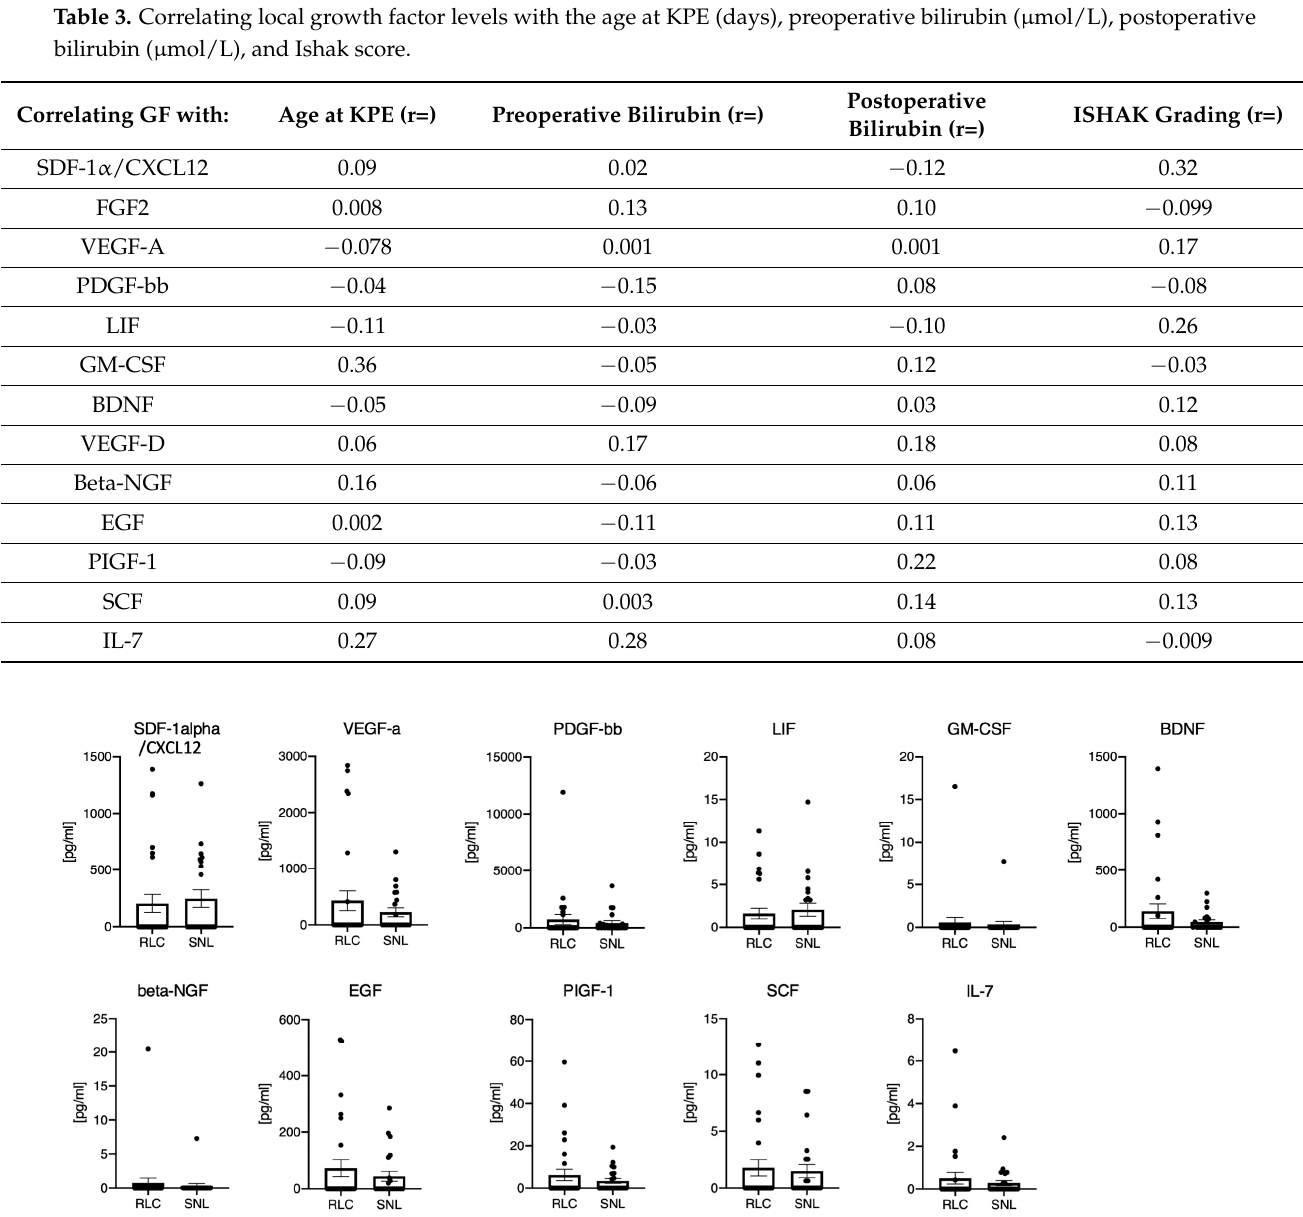
Table 4. Systemic growth factor profile.